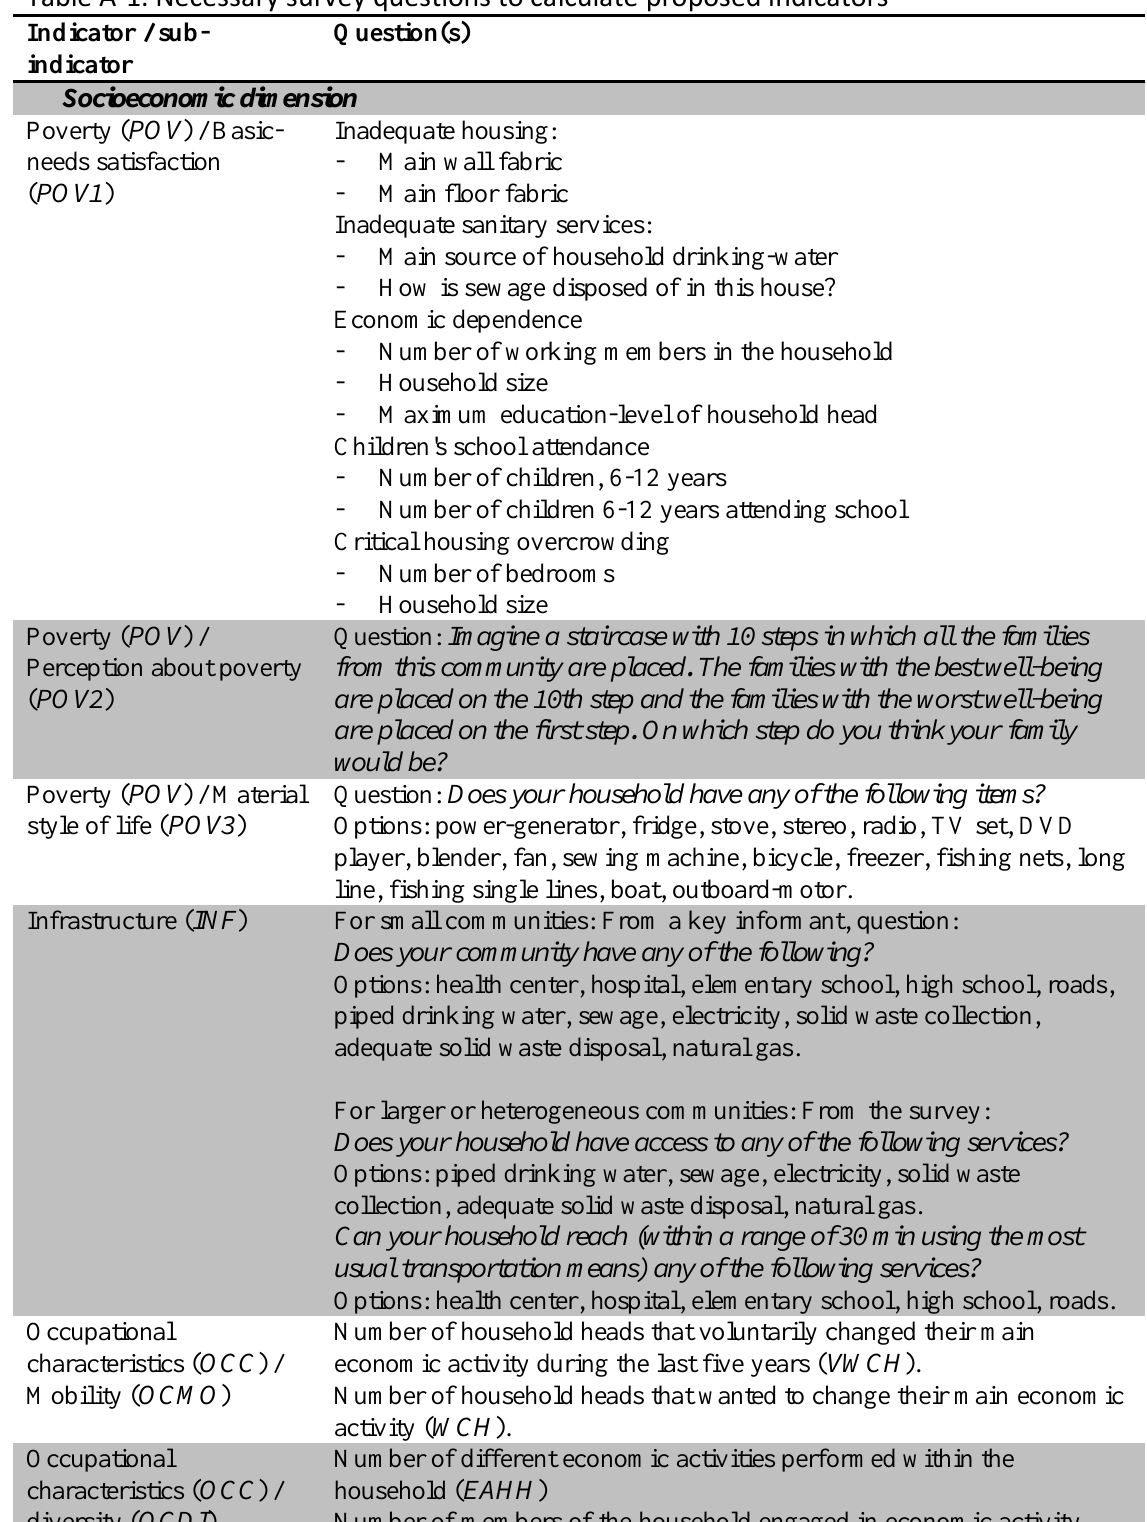
Table A-1. Necessary survey questions to calculate proposed indicators Indicator /